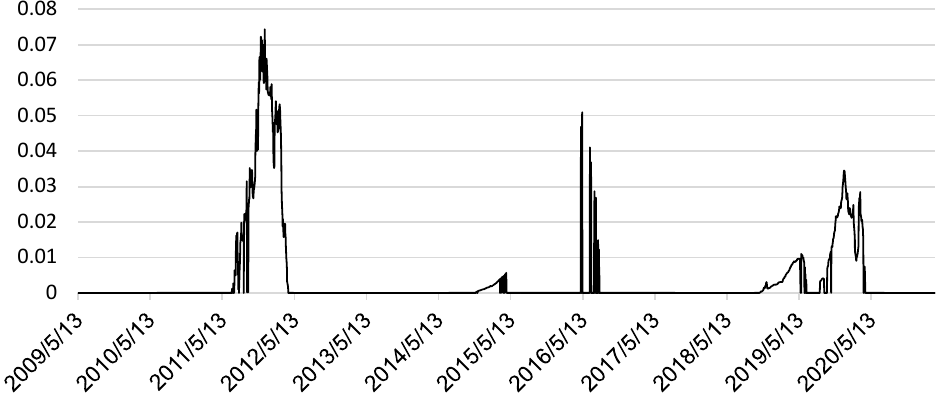
Figure 5. Estimates of the gamma parameter in formula (30) for a moving window of size 504.